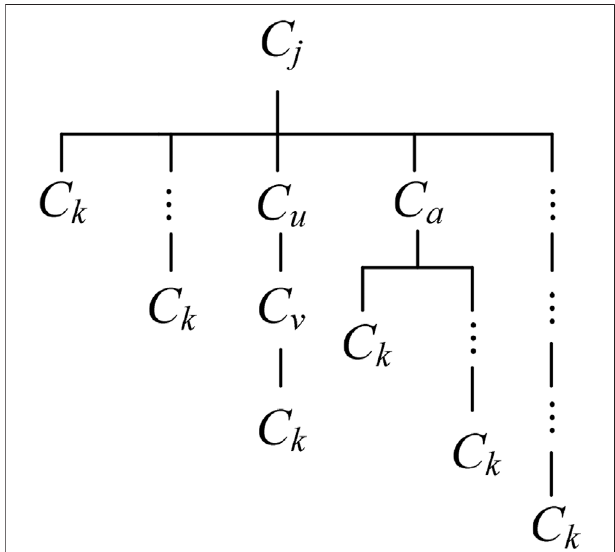
FIGURE 4 | Change propagation